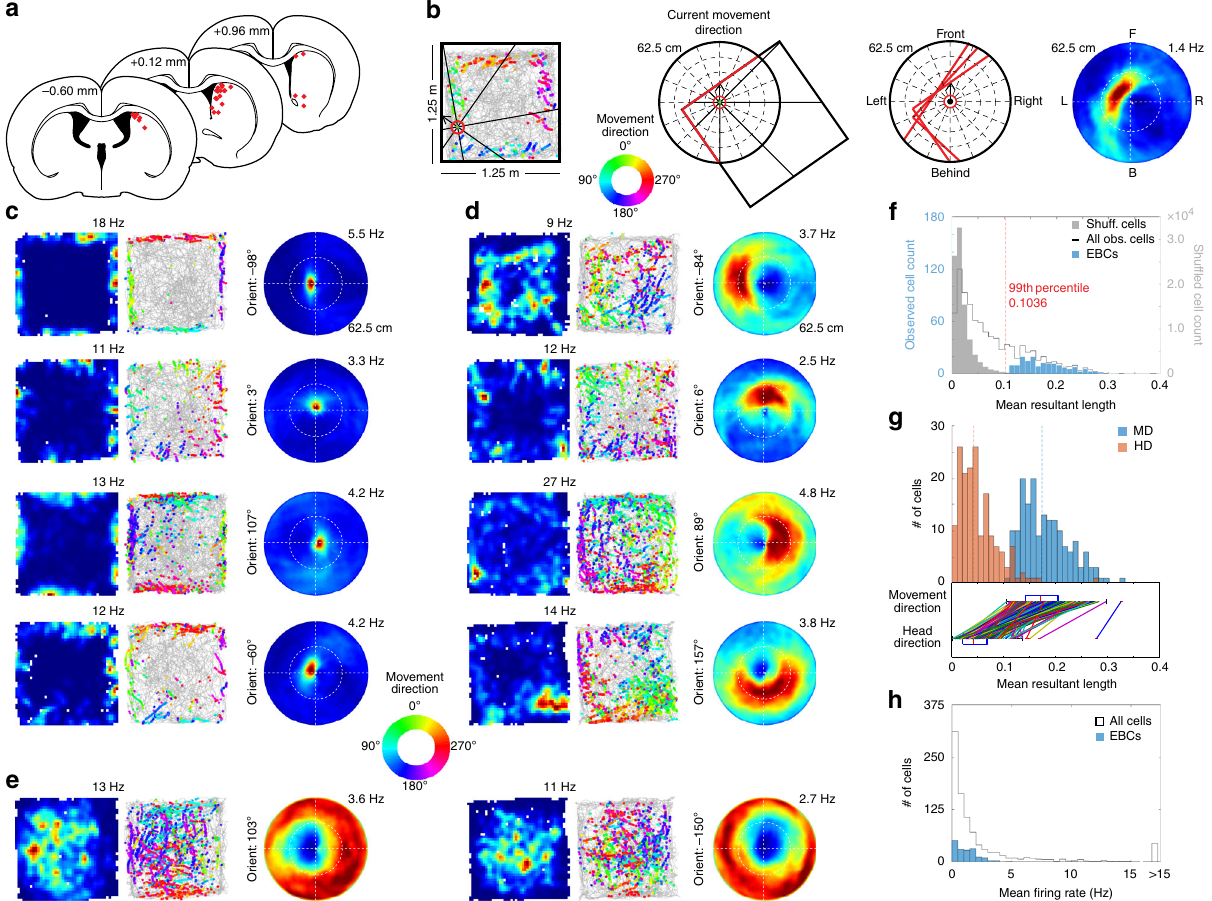
Fig. 1 Dorsomedial striatal cells respond to environmental boundaries in an egocentric reference frame. a Final tetrode positions. Diagrams were reprinted from The rat brain in stereotaxic coordinates, 7th edition, Paxinos, G. & Watson, C., pages 97, 111 and 123, Copyright 2014, with permission from Elsevier 26 . b Egocentric boundary ratemap generation (see Methods and Supplementary Fig. 3). c Columns show allocentric spatial ratemaps, trajectory plots with color-coded movement direction spike locations (color wheel legend shown in fi gure), and egocentric boundary ratemaps for four example egocentric boundary cells (EBCs) with different preferred orientations and a preferred distance close to the animal. The maximum fi ring rate for each allocentric and egocentric ratemap is displayed above the top right corner of each plot. d Same as in c , but for EBCs with preferred distances distant from the animal. e Same plots as above, but for two inverse EBCs. f Distribution of mean resultant length for observed and shuf fl ed cells. g Distribution of mean resultant lengths for EBCs using movement direction and head direction. h Distribution of mean fi ring